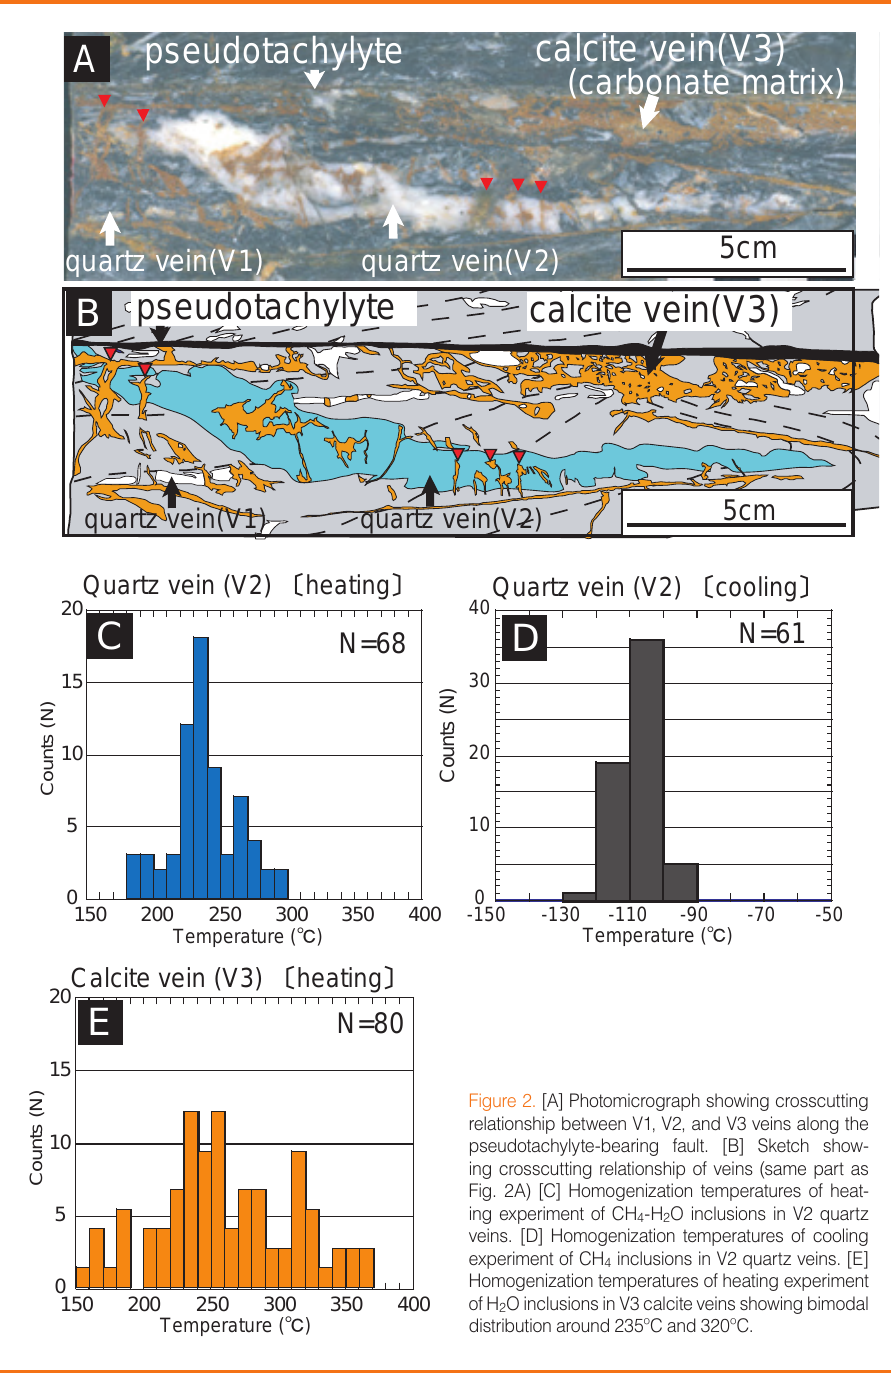
Figure 2. [A] Photomicrograph showing crosscutting relationship between V1, V2, and V3 veins along the pseudotachylyte-bearing fault. [B] Sketch show- ing crosscutting relationship of veins (same part as Fig. 2A) [C] Homogenization temperatures of heat- ing experiment of CH 4 -H 2 O inclusions in V2 quartz veins. [D] Homogenization temperatures of cooling experiment of CH 4 inclusions in V2 quartz veins. [E] Homogenization temperatures of heating experiment of H 2 O inclusions in V3 calcite veins showing bimodal distribution around 235ºC and